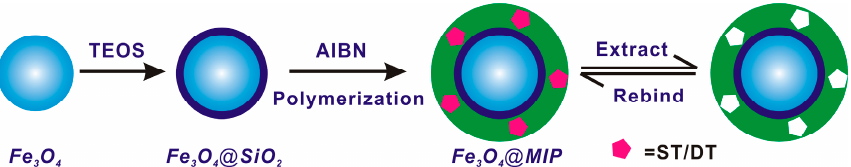
Figure 1. Schematic illustration of Fe 3 O 4 -involved magnetic molecularly imprinted polymers for sensitive and specific recognition of sterigmatocystin. TEOS: tetraethyl ortosilicate; AIBN: 2,2-azobisisobutyronitrile; MIP: molecularly imprinted polymers; ST: sterigmatocystin; DT: 1,8-dihydroxyanthraquinone.